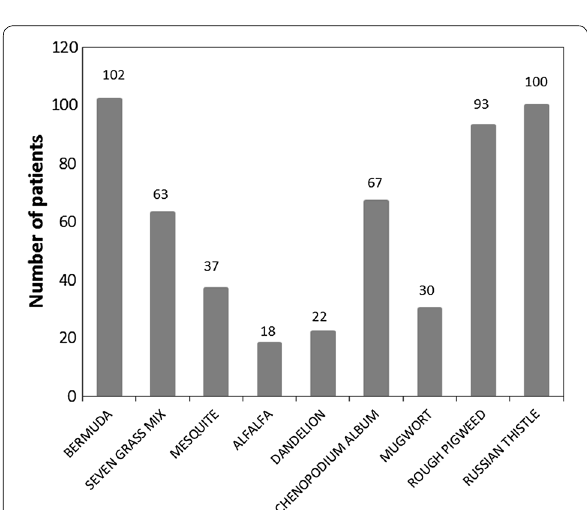
Fig. 3 Frequency of sensitization to individual pollen allergens (n 204). Some patients have more than one allergen =